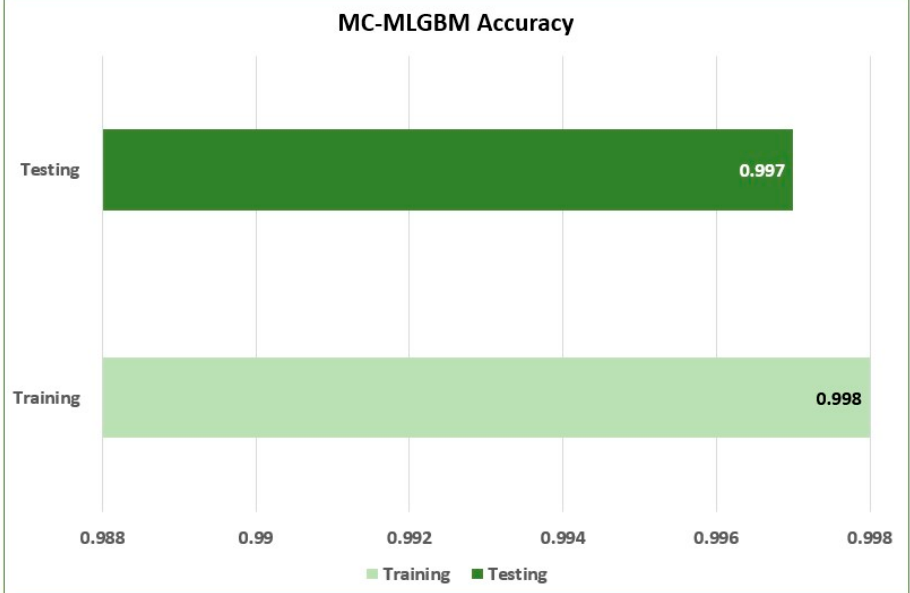
Figure 5. Training and testing accuracy of the proposed model.